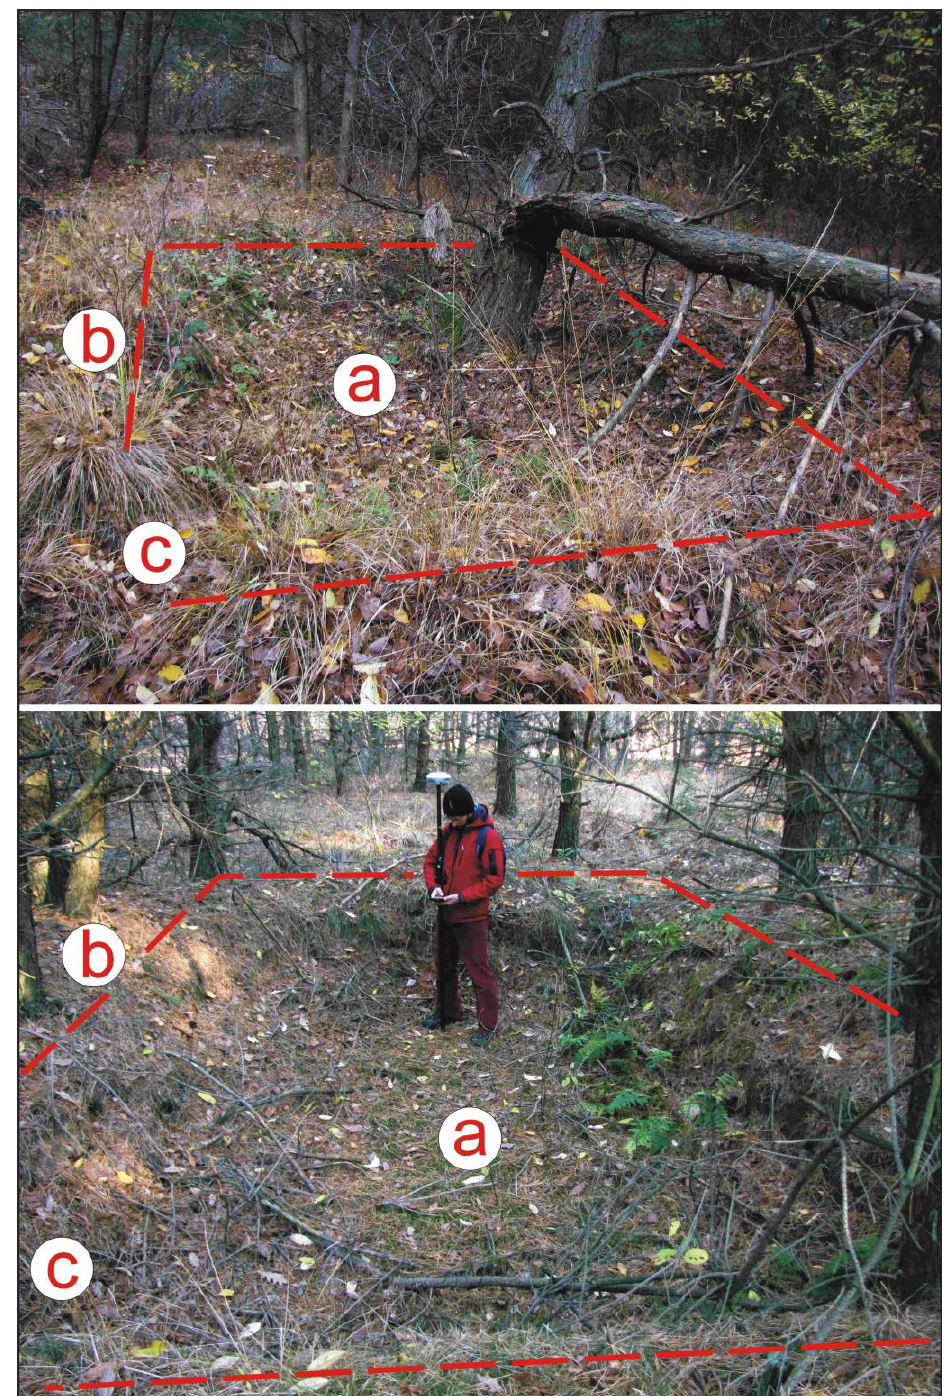
Figure 4. Two of the 11 forest dugouts: (a) depression; (b) surrounding embankment; (c) entry (photo: J.M. Waga). (photo: J.M.